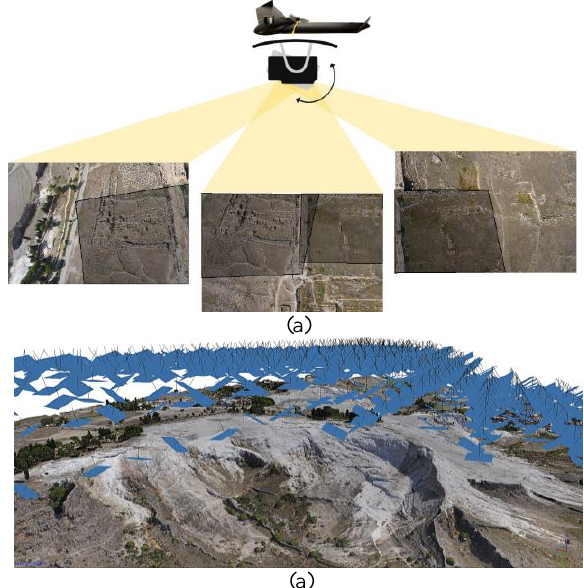
Figure 2. The images acquisition: (a) the triplet 1 nadir and 2 oblique with the overlapping area; (b) the oriented images block overlooking the limestone hill